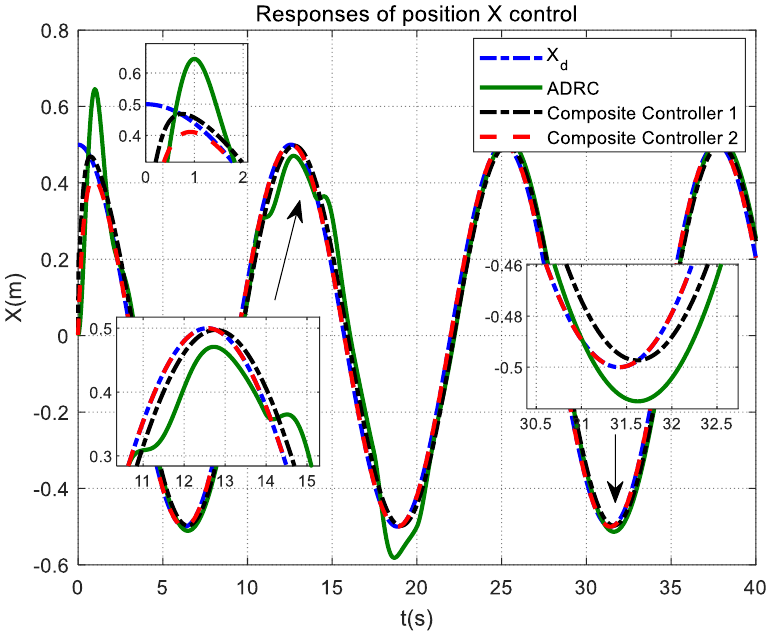
Figure 8. Responses of position X control for QUAV under actuator constant fault and disturbance condition.